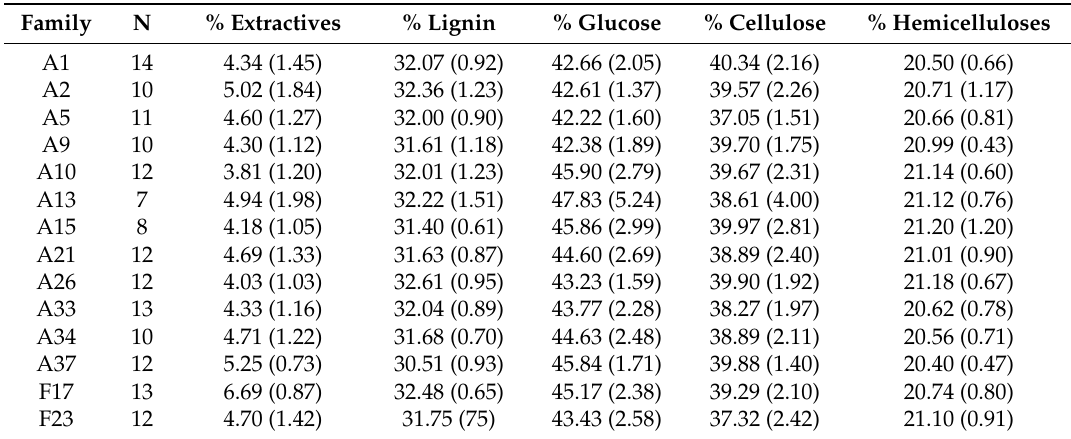
Table 5. Chemical traits of elite loblolly pine families on the Florida site.